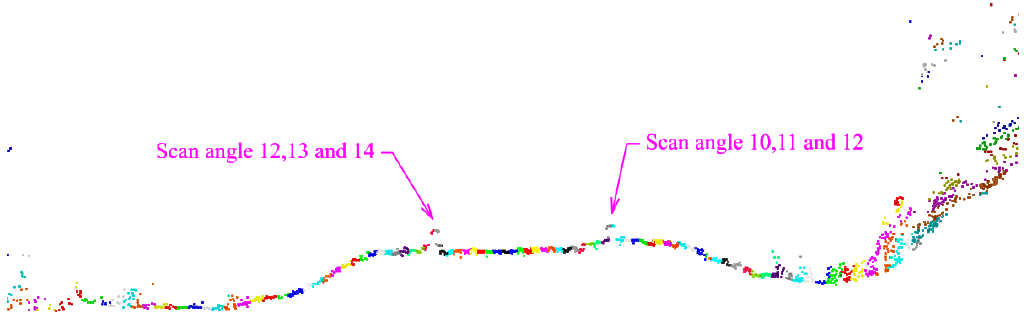
Figure7. Scananglecolouredcloudcross-sectionandscananglevaluesforrailtracksclassificationpoint. Figure 7. Scan angle coloured cloud cross-section and scan angle values for rail tracks classification point.